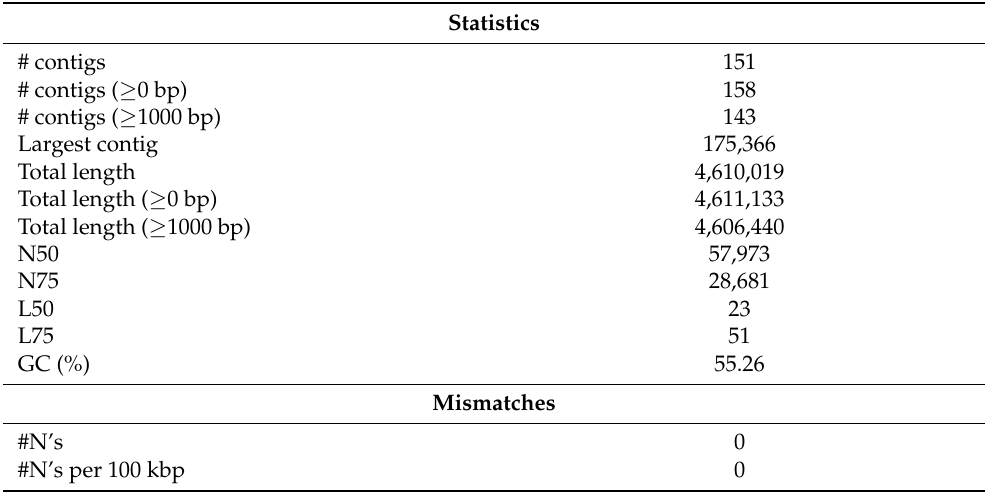
Table 1. Quality assessment for SRS89 strain